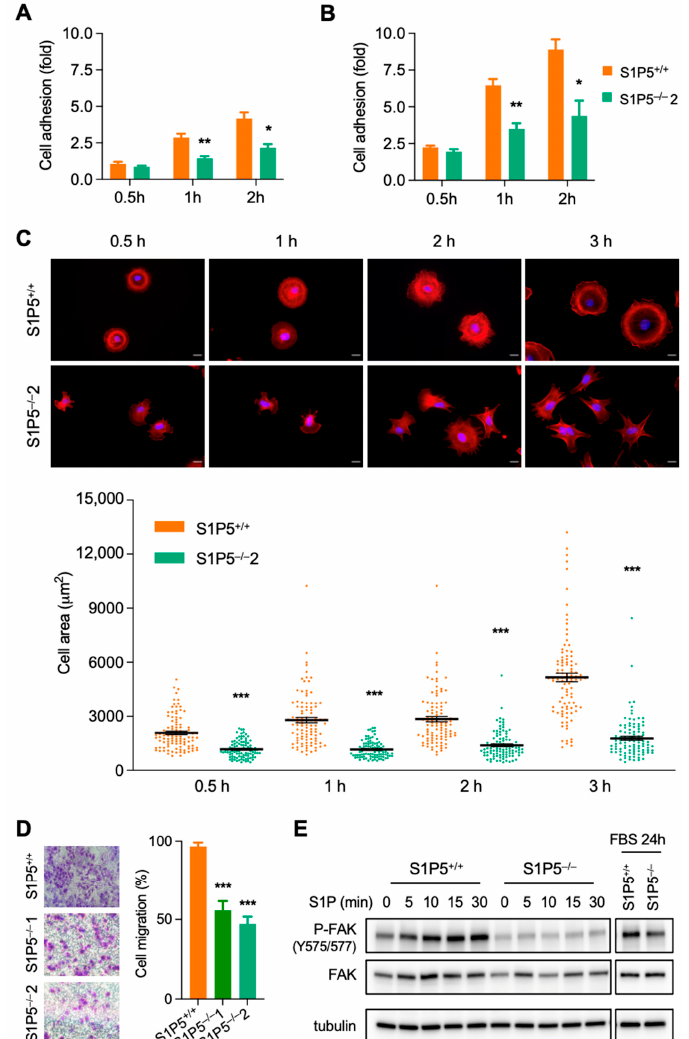
Figure 3. Impaired adhesion, spreading and migration in S1P5 − / − cells. S1P5 +/+ and S1P5 − / − MEFs were plated in non-coated ( A ) or fibronectin-coated ( B ) 24-well plates and incubated for 0.5, 1, and 2 h. Cells were washed and the adherent cells were stained with crystal violet, and the staining intensity was quantified by spectrophotometry at 595 nm. The results represent fold cell adhesion (of wild-type cells) and are means ± SEM of three independent experiments (**, p < 0.0083; *, p < 0.0149; **, p < 0.0073; *, p < 0.0226). ( C ), cell spreading and actin organization in S1P5 − / − cells. S1P5 +/+ and S1P5 − / − 2 MEFs were plated on coverslips for the indicated times, fixed and stained for F-Actin (Phalloidin-red) and DNA (Hoechst 33,342-blue). The upper panel shows representative images. Scale bar: 10 µ m. The lower panel shows the quantification of the cell area (in µ m 2 ) based on F-Actin staining. The mean surface area from 100 individual cells was calculated using the ImageJ software. The data are shown as dot plot, where each point represents one cell and the black lines indicate means ± SEM (***, p < 0.0001). ( D ), equal numbers of S1P5 +/+ and S1P5 − / − MEF cells were seeded in 8- µ m pore Transwell cell culture inserts and incubated for 8 h. The cells that migrated to the bottom of the well were fixed and stained with crystal violet. The left panel shows representative images and the right panel the relative migration (expressed as percentage of control cells). The means ± SEM from four experiments is shown (***, p < 0.0001). ( E ), impaired FAK phosphorylation in S1P5 − / − MEFs. S1P5 +/+ and S1P5 − / − cells were serum-starved for 4 h and then treated with S1P (1 µ M) for the indicated times or grown in medium containing 10% FBS for 24 h (right panel). Total cell extracts were analyzed by SDS/PAGE with antibodies against phosphorylated FAK, FAK and